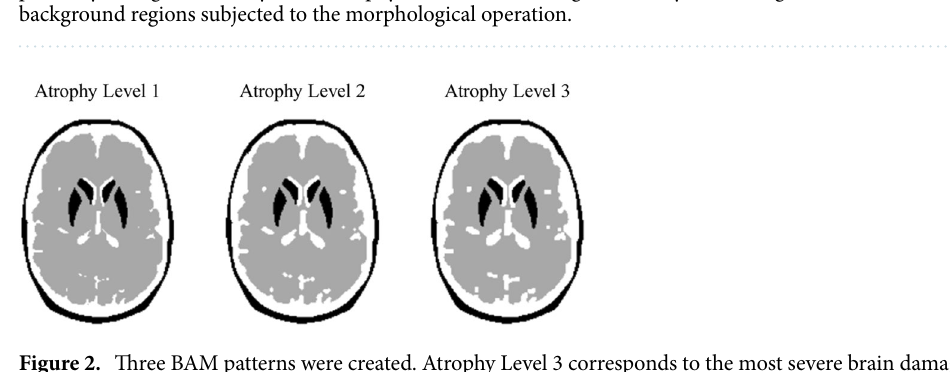
Figure 2. Three BAM patterns were created. Atrophy Level 3 corresponds to the most severe brain damage. By contrast, atrophy Level 1 corresponds to the original Zubal head phantom where no morphological operation is